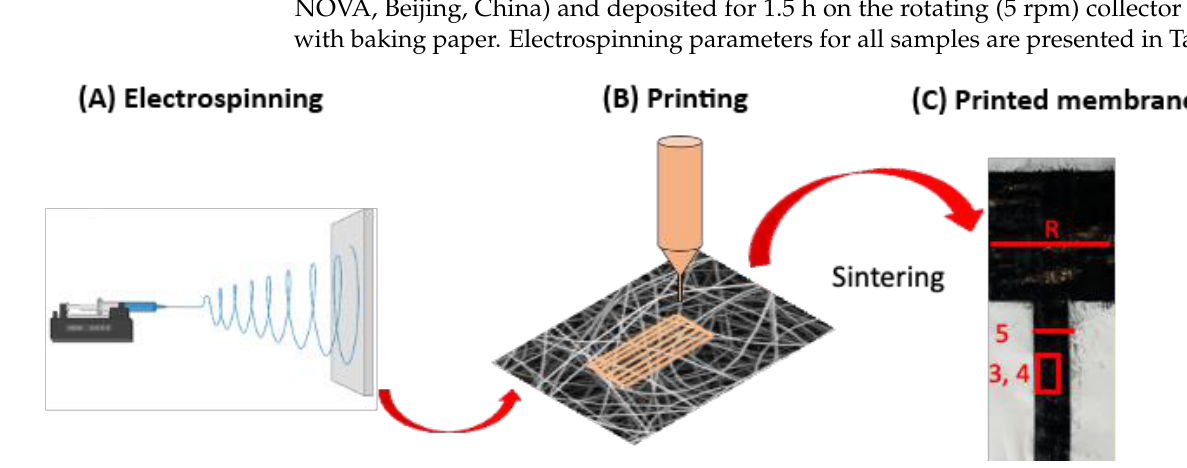
Figure 1. The schematic diagram representing all stages of fabrication of conducting path on electrospun fibers, consisting of ( A ) electrospinning the polymer membrane, ( B ) printing conductive inks directly on electrospun membranes and ( C ) sintering processes of printed ink on polymer fibers with marked locations of image regions via SEM in Figures 3–5 on the printed profiles for all samples. Table 1. Summary of all the electrospinning parameters to produce PVB, PS and PI electrospun membranes.